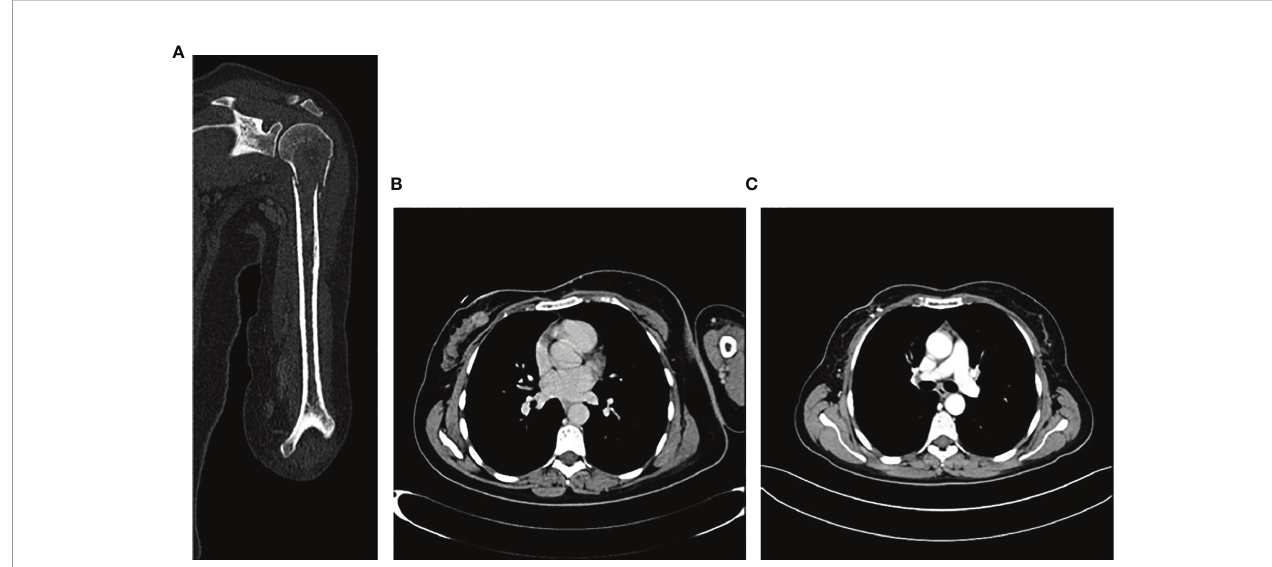
FIGURE 4 | Imaging of bone lesion in the left homerus (A) , and the locally advanced breast cancer at the time of diagnosis in March 2019 (B) and after 6 months of treatment (C)